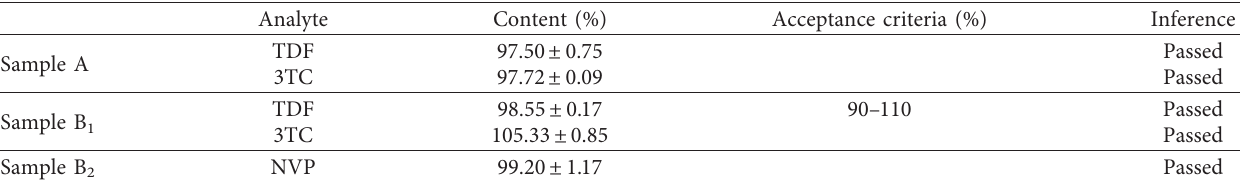
Figure 3: Stability of analytes in test solution within 6-hour period. (a) 3TC, (b) NVP, and (c) TDF. Table 4: Percentage content obtained for sampled